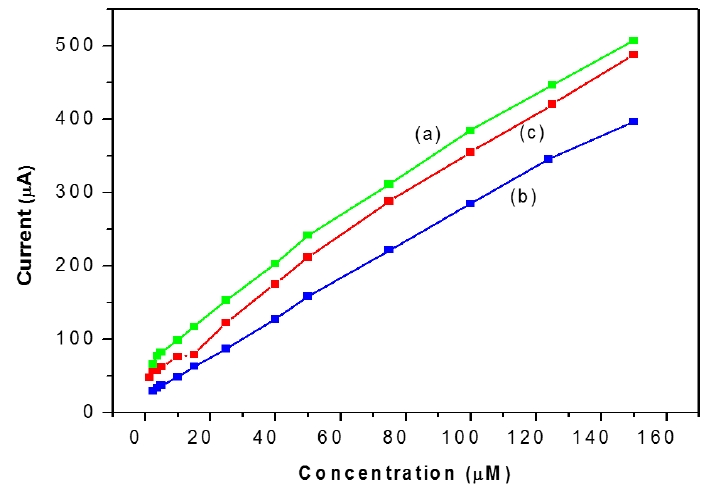
Figure 6. Calibration curve of the biosensor as a function of the concentrations of catechol: ( a ) NAF/LAC; ( b ) TiO 2 /LAC; and ( c ) TiO 2 /NAF/LAC.